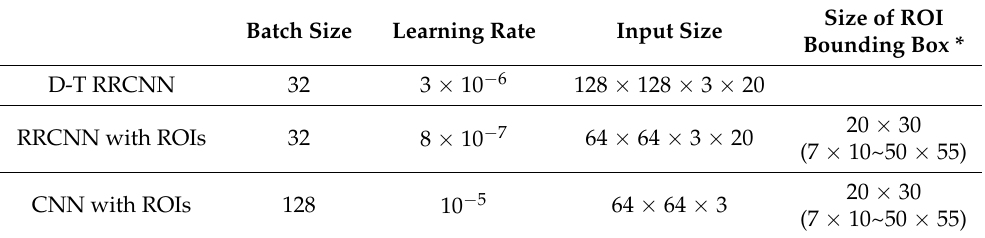
Size of ROI Bounding Box * 20 × 30 (7 × 10~50 × 55)